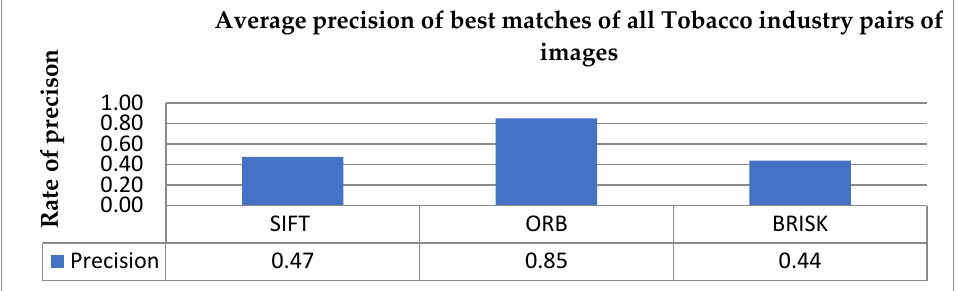
Figure 22. Average precision matching from all pairs of images.